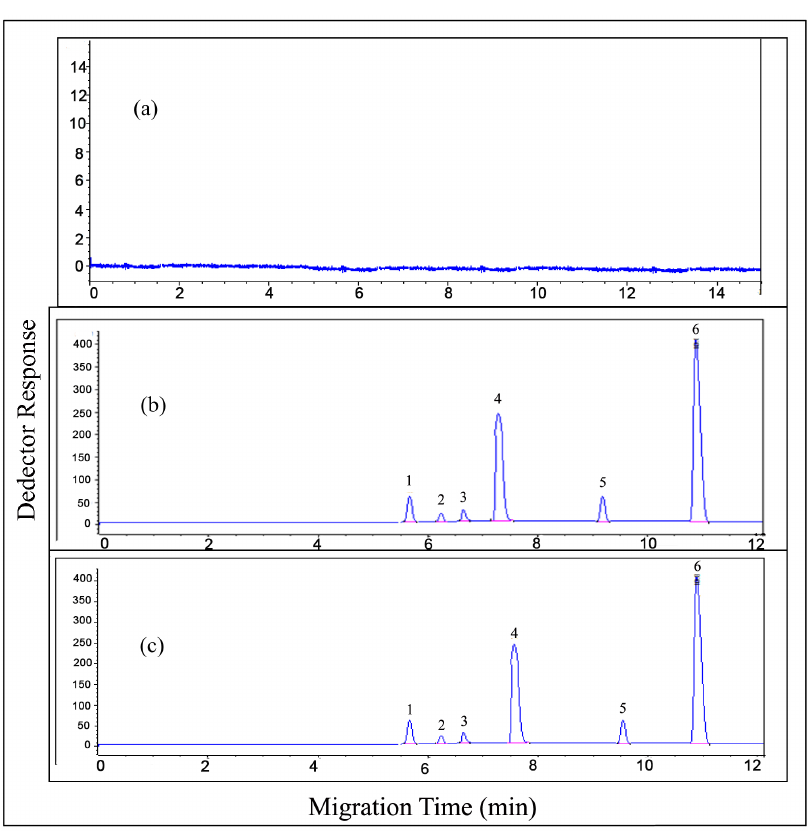
Figure 3 - Electropherograms at λ=192nm, a)BGE solution, b)Standard solutions of DEX, EPH, CHL, PSE, 4-AP, PAR, respectively, c)Solution containing pharmaceutical preparation (Gripamol tablet) and impurities, Conditions: t